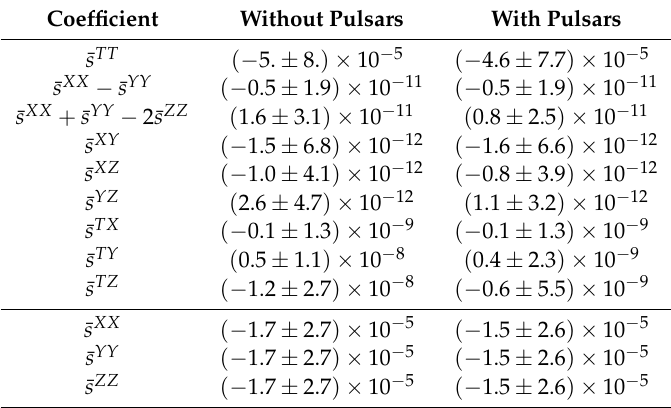
Table 9. Estimation of SME coefficients resulting from a fit combining results from: atomic